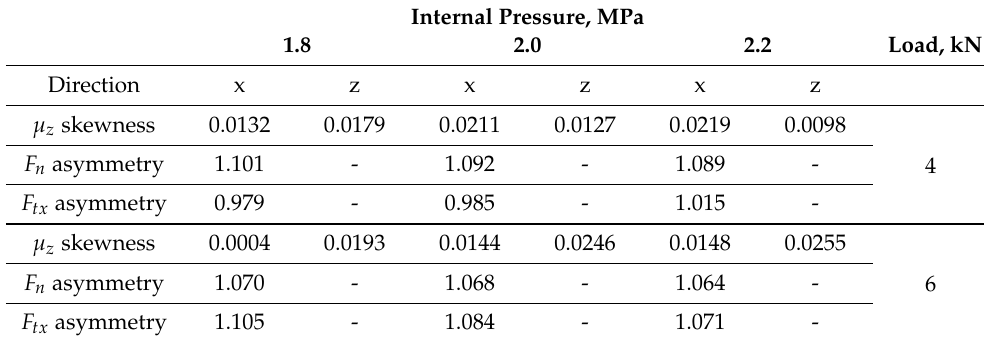
Figure 9. Friction µ z , normal F n and tangential F tz force distribution on the tyre–asphalt interface for pressures 0.2 ( a ), 0.18 ( b ) and 0.22 ( c ) MPa under a ∼ 6 kN load. Table 2. Skewness of friction coefficients and normal force